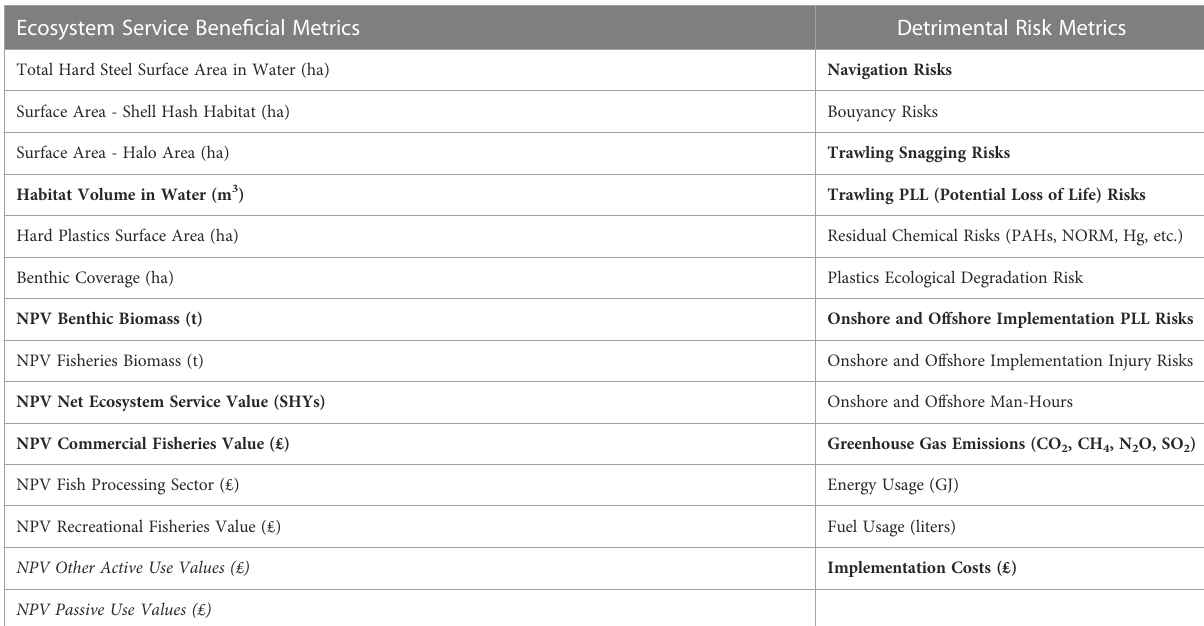
TABLE 2 North Sea Case Study Metrics (metrics bolded were plotted in